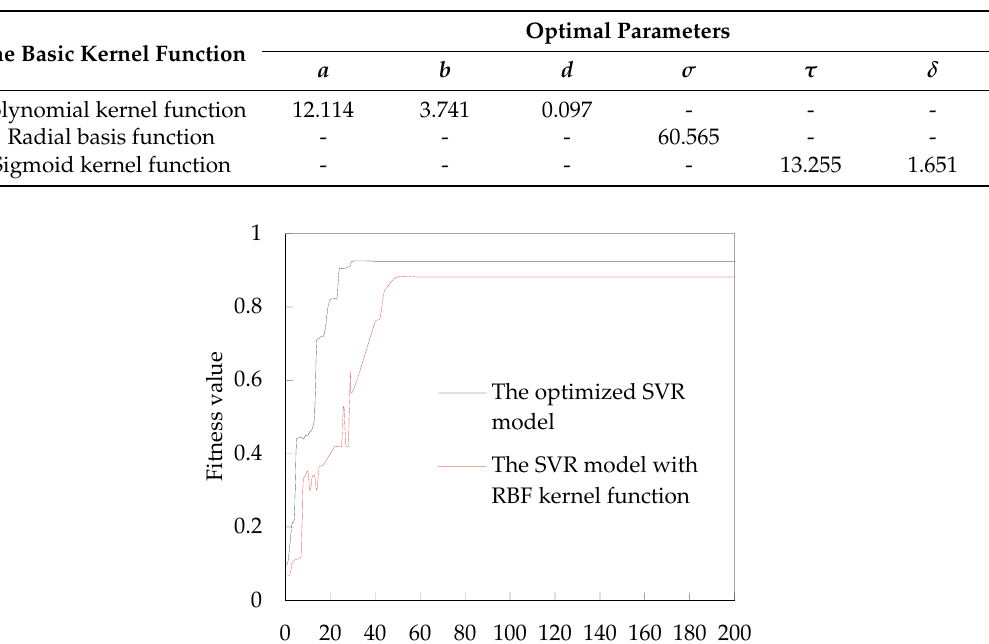
Table 3. The best parameters of each basic kernel function.